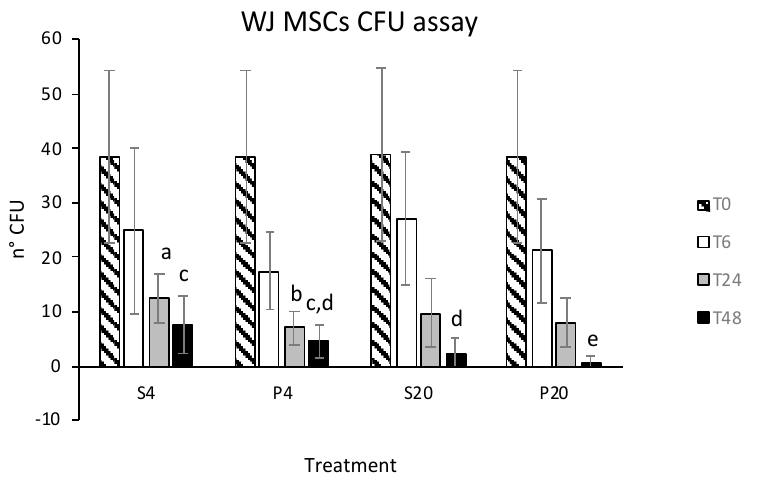
Figure 4. Number of CFU formed by eWJMSCs after storage for 6 (T6), 24 (T24), and 48 (T48) hrs in saline solution (S) and plasma (P) at 4°C (4) and room temperature (20): a vs. b; c vs. d vs. e: p < 0.05.